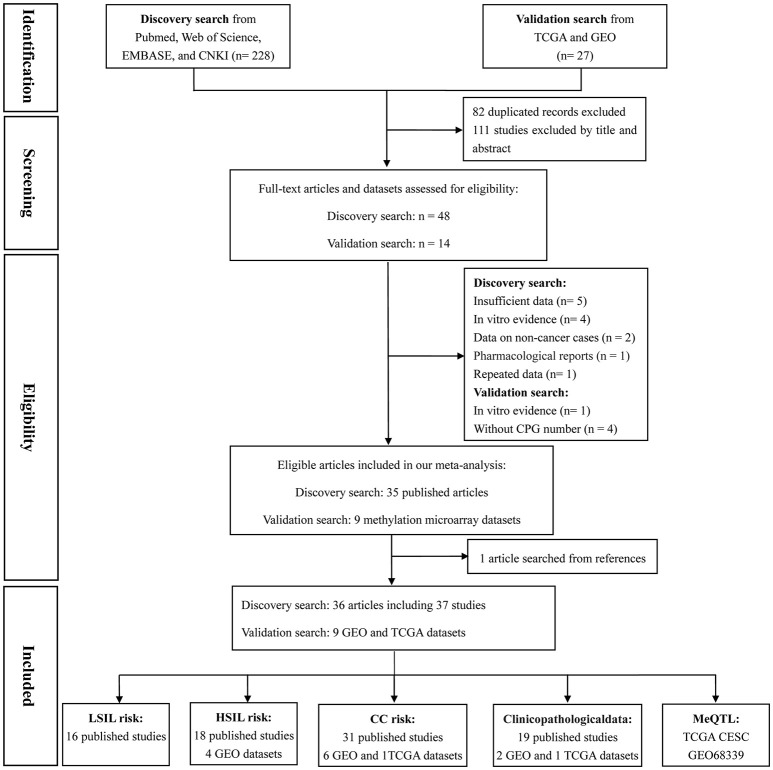
Flow chart of study selection process.